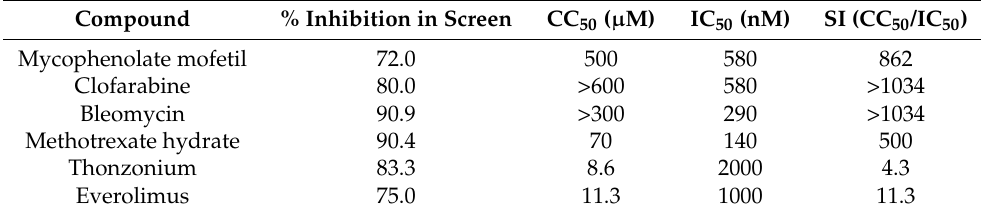
Table 1. Anti-SFTSV activity and cytotoxicity of six selected drug compounds. Compound % Inhibition in